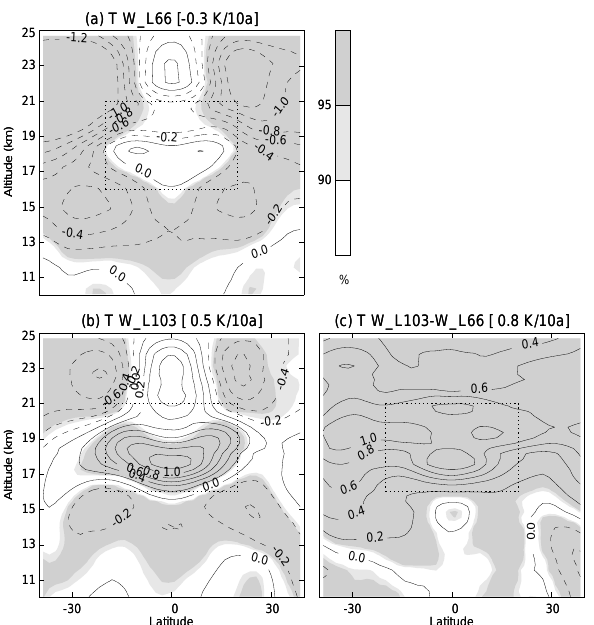
Figure 8. (a, b) Latitude–height sections of temperature trends over 2001–2010 from the W_L103 and W_L66 experiments respec- tively. (c) The differences between (a) and (b) . Contour interval is 0.2Kdecade − 1 and grey shading represents statistically significant trends. The temperature trends in the W_L103 and W_L66 runs are calculated by multiple linear regression for each three simulations.